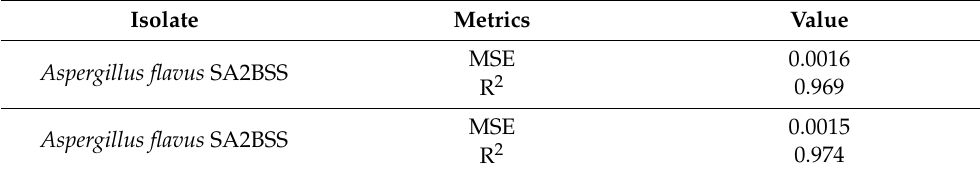
Table 10. The autoencoder network training results in ANN modeling.